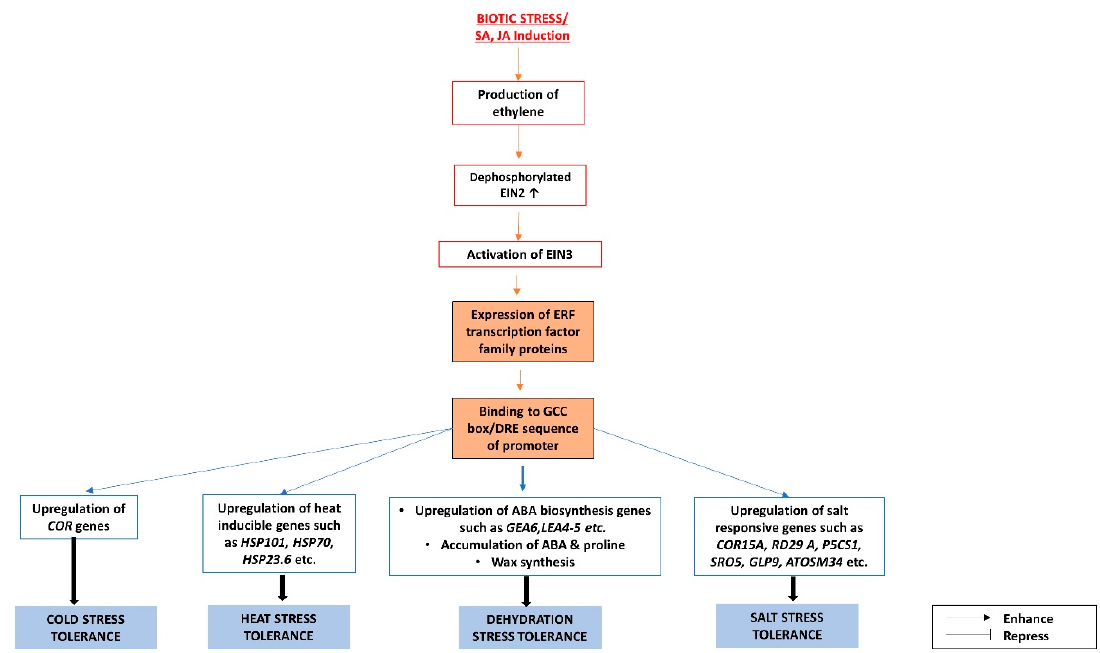
Figure 2. The interactions between abscisic acid (ABA) and ethylene signaling pathways under biotic and abiotic stresses are mediated through Ethylene Response Factors (ERFs).